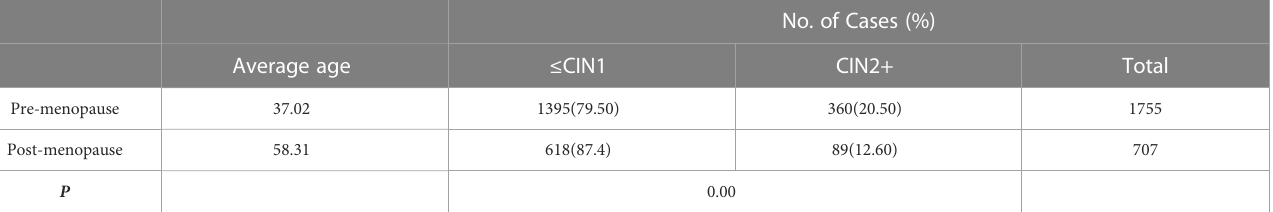
TABLE 2 The histopathologic results for pre- and post-menopausal women with